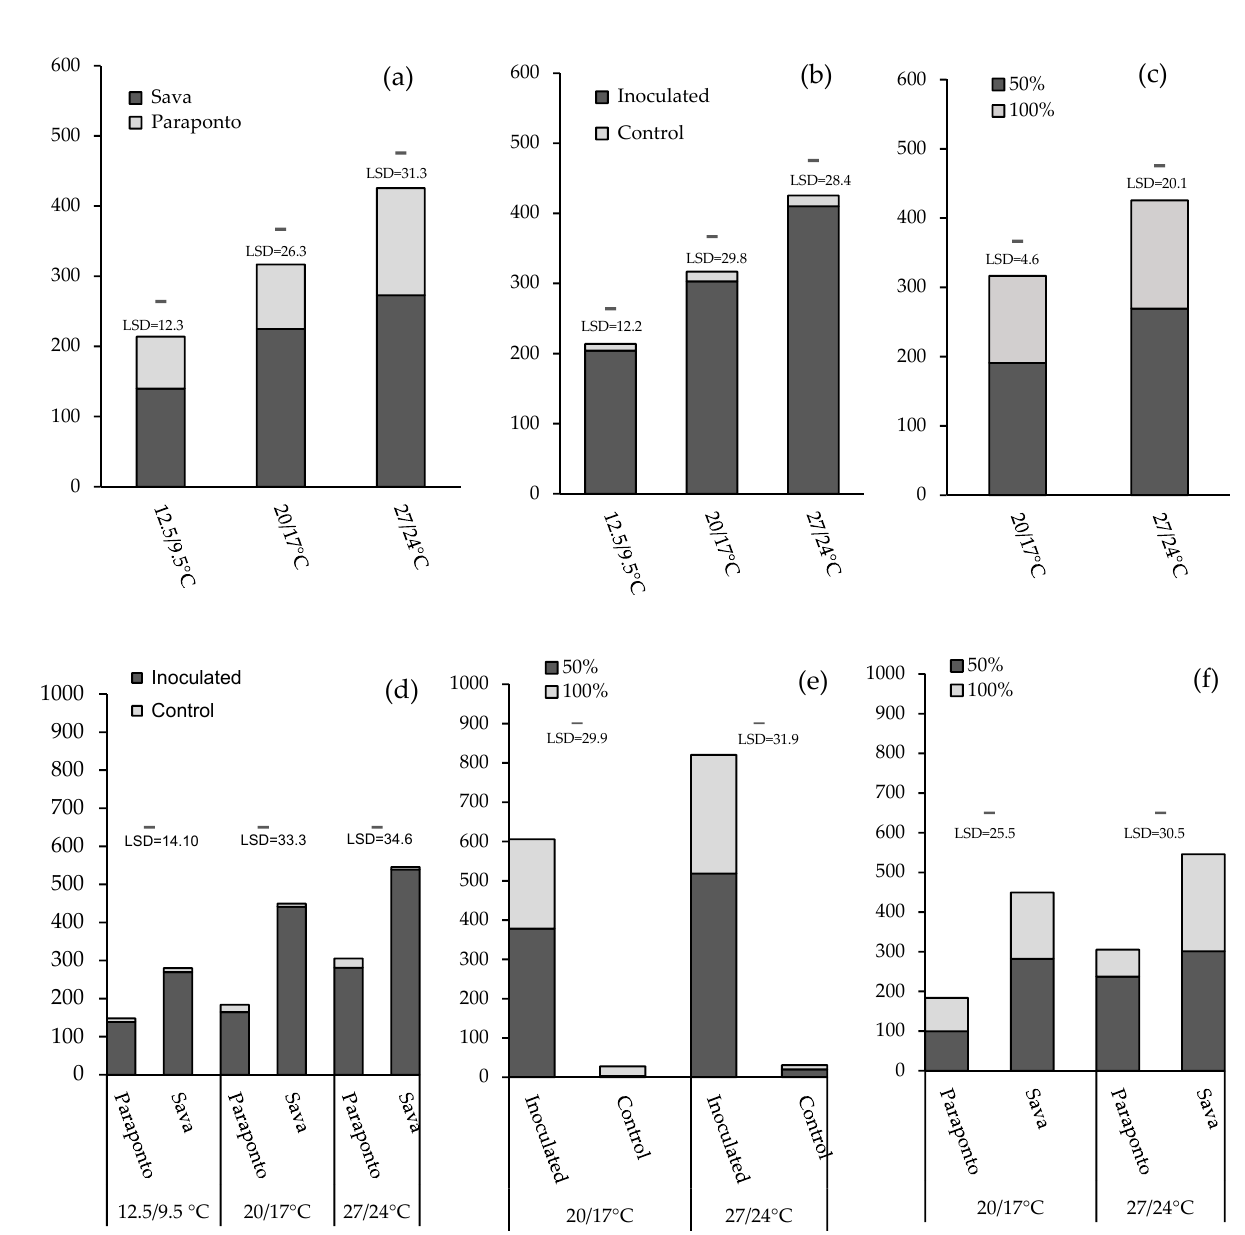
Figure 2. The bar charts show the effect of three different temperature regimes (12.5/9.5 ◦ C, 20/17 ◦ C, and 27/24 ◦ C, day/night) and two different moisture levels (100% and 50% water holding capacity) across control and inoculated plants of annual Medicago rugosa cv. Paraponto and M. scutellata cv. Sava on the content of coumestrol. Data shown represent mean coumestrol content values in relation to ( a ) main effect of species at three different temperatures; ( b ) main effect of inoculation at three different temperatures; ( c ) main effect of moisture at 20/17 ◦ C and 27/24 ◦ C; ( d ) two-way interactions of species and inoculation at 20/17 ◦ C and 27/24 ◦ C; ( e ) two-way interactions of inoculation and moisture level at 20/17 ◦ C and 27/24 ◦ C; ( f ) two-way interactions of species and moisture level at 20/17 ◦ C and 27/24 ◦